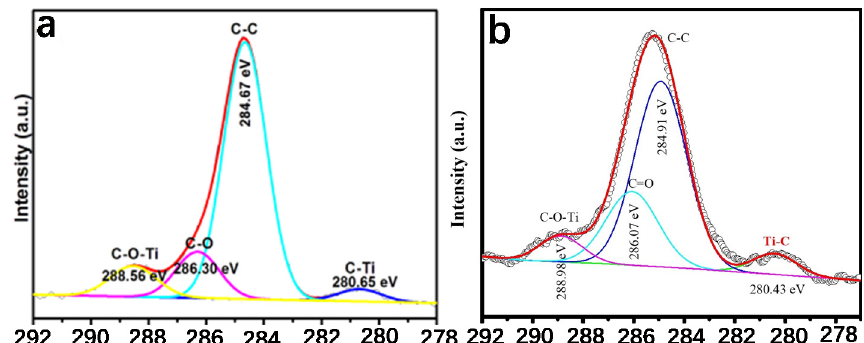
Figure 2. The existence of Ti–C bond in the XPS spectra of C1s ( a ) [14] and ( b )